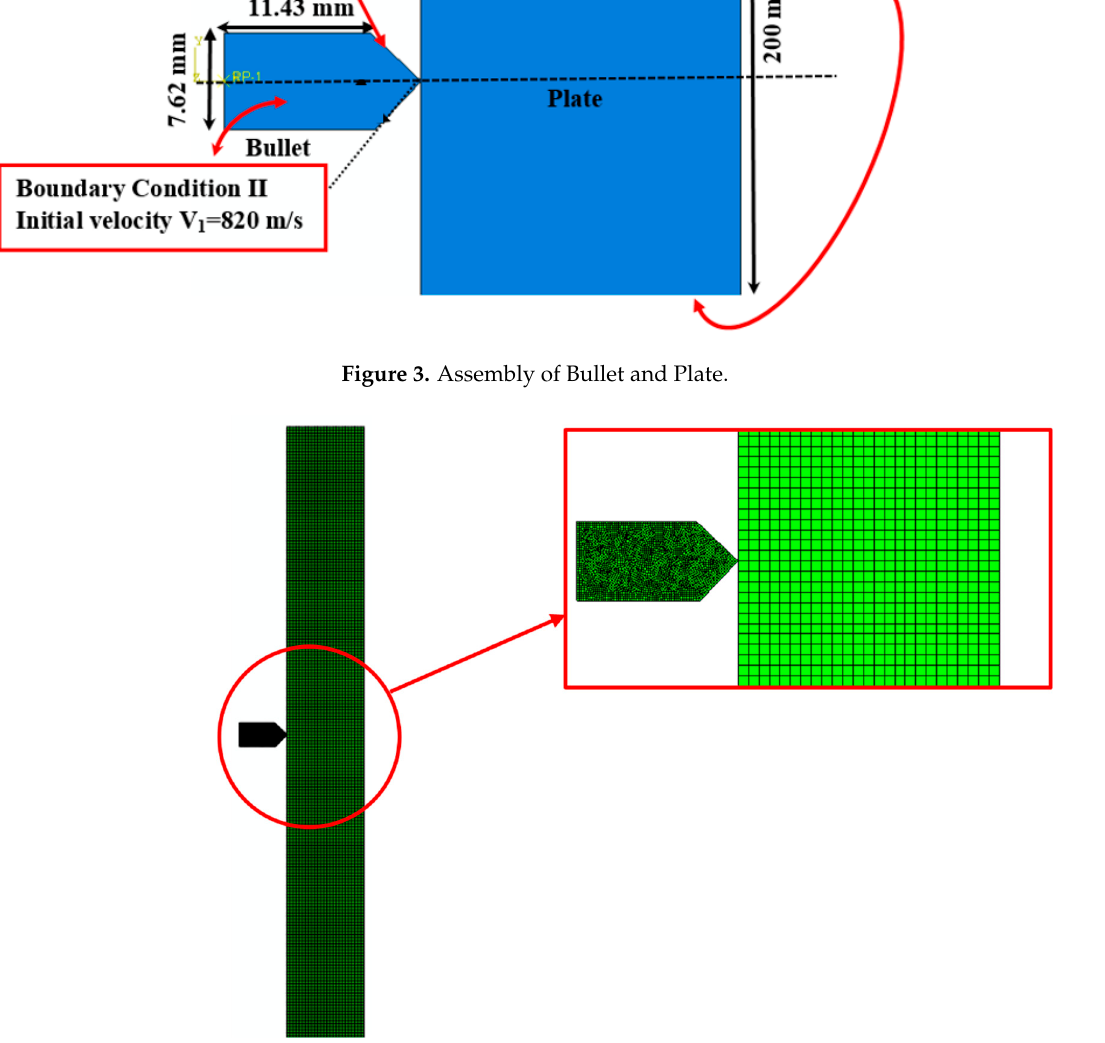
Figure 4. Meshing of 7.62 AP steel bullet core and target plate. Bullet and plate both are make as deformable bodies. Bullet has been created an impact on the plate with a velocity of 820 m/s. At the same velocity Bullet strikes the base